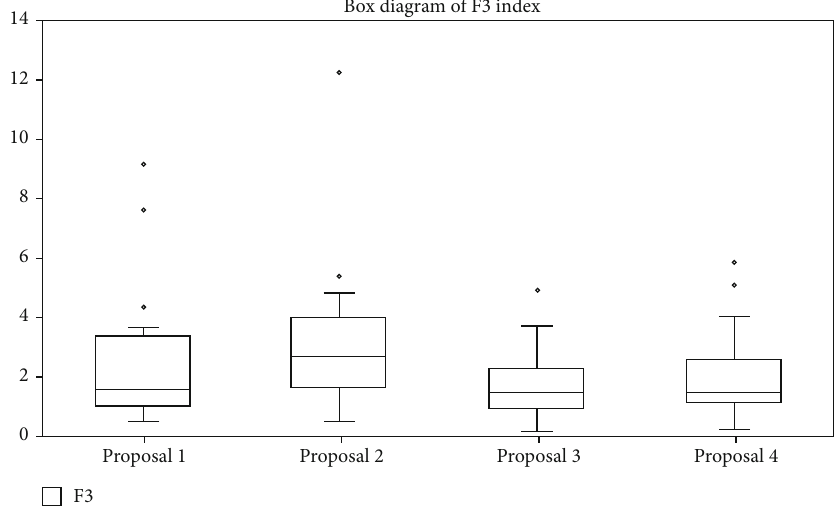
Figure 6: Box diagram of the F3 index. Table 8: F3 index data sheet. Table 9: Variance con fi dence interval data in the F3